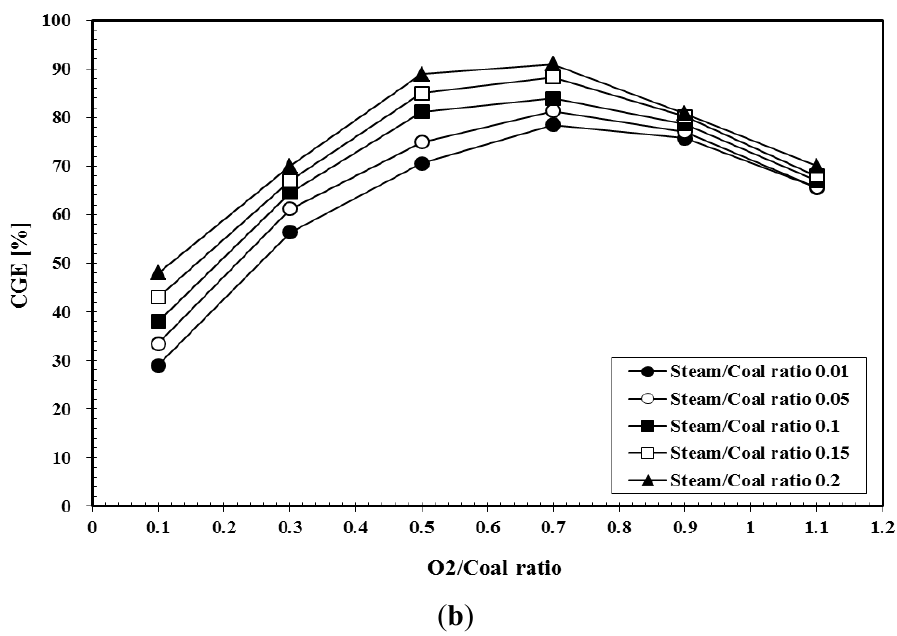
Figure 9. Efficiencies at outlet with respect to the O 2 /coal and steam/coal ratios. ( a ) Carbon conversion efficiency (CCE); ( b ) Cold gas efficiency (CGE).